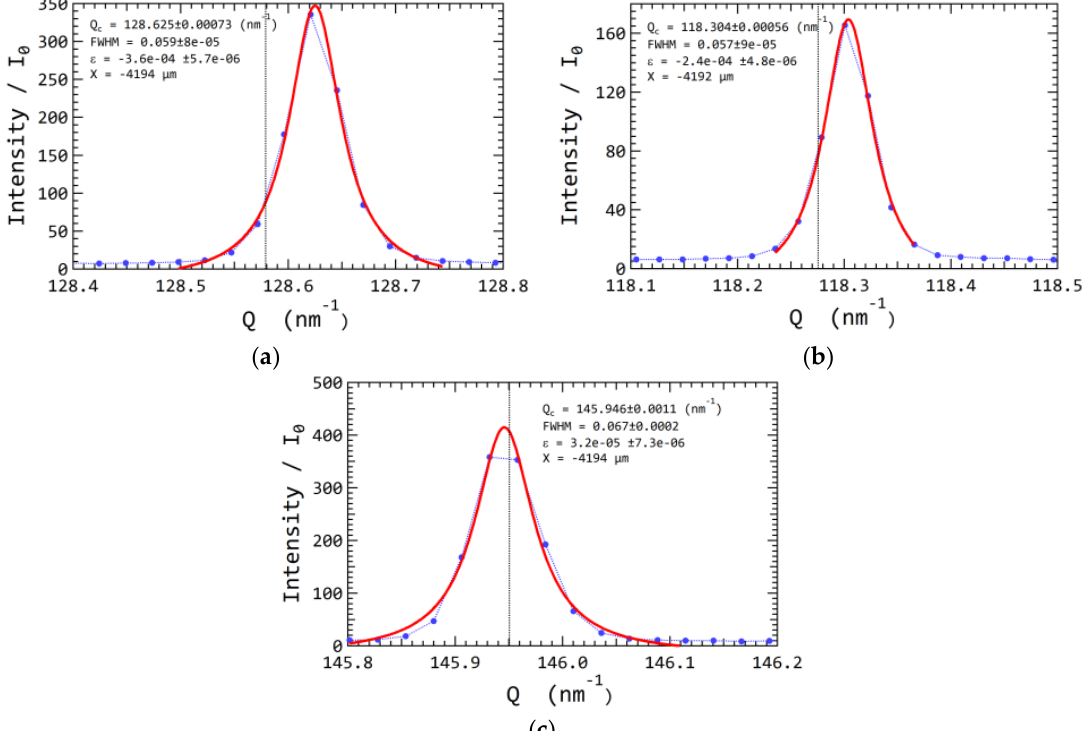
Figure 8. ( a – c ) Intensity distribution as a function of diffraction vector Q for three Laue spots for the three grains 1 – 3 marked in Figure 7a, respectively. The red lines are the fitted results using a Gaussian function.